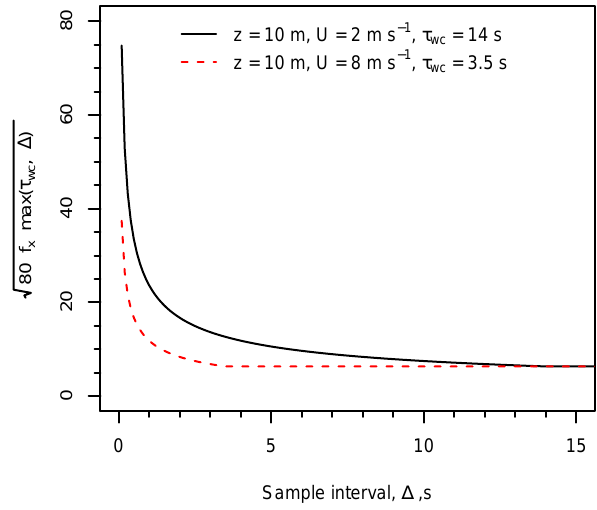
Fig. 1. As the sample interval is increased from 0.1s, typical of con- ventional eddy covariance, to values exceeding the covariance inte- gral time scale, τ wc , covering the range of disjunct eddy covariance, a greater requirement is placed on sensor precision, as indicated by the decreasing value of the radical term in Eq.